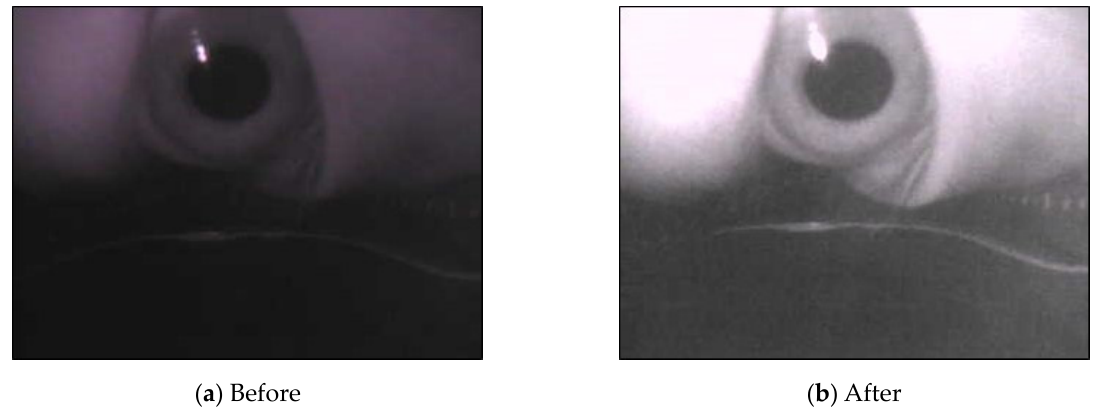
Figure 10. Results after setting USB video device class (UVC) parameters.